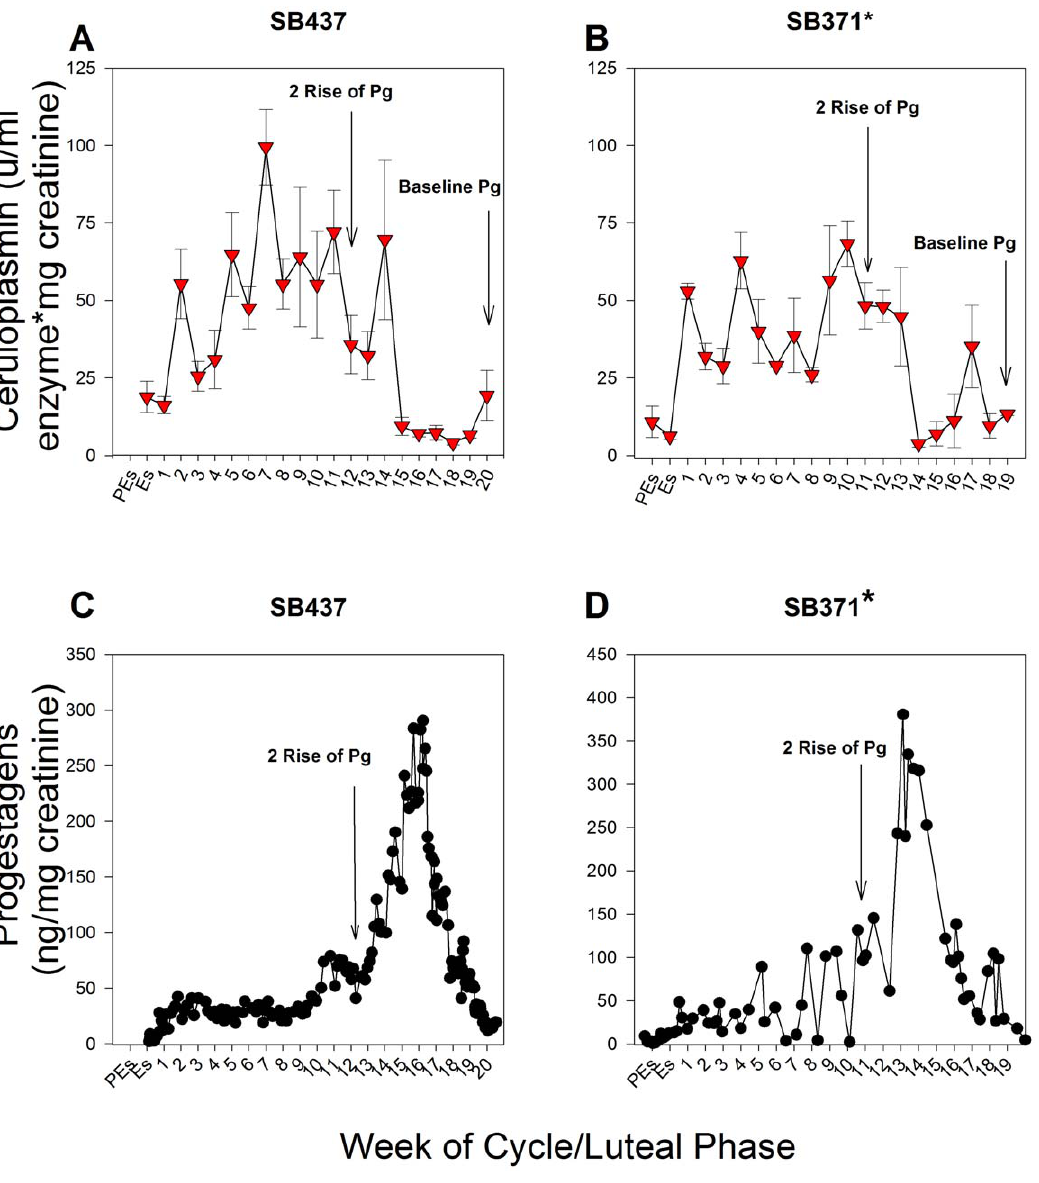
Figure 5. Representative patterns of active urinary ceruloplasmin and urinary progestagens in bred/no birth cycles for female giant pandas: suspected lost pregnancies based on ceruloplasmin. The levels of active urinary ceruloplasmin in 2008 for SB437 (SNZP; Panel 5A) and 2001 for SB371 (SDZ; Panel 5B). Both animals were artificially inseminated. Panels 5C and D: The levels of urinary progestagens for SB437 in 2008 (5C) and for SB371 in 2001 (4D). Red diamonds represent the levels active urinary ceruloplasmin; Black circles represent urinary progestagen concentrations; Pg=Progestagen; PEs=Proestrus; Es=Estrus; Numerical numbers=weeks of the luteal phase. Variations in the x axis exist to accommodate variable concentrations and durations. Data are weekly means 6 SEM; n=6 reproductive cycles, representative cycles (n=2) are presented herein. *Samples from cycles obtained from SB371 were analyzed blind, without prior knowledge of cycle outcome. Because urinary progestagen concentrations for SB371 were analyzed using a different antibody, caution must be taken when directly comparing progestagen data between SB371 and the other animals. However, the same trends were observed in the relationship between active ceruloplasmin and progestagens in urine using both antibodies.